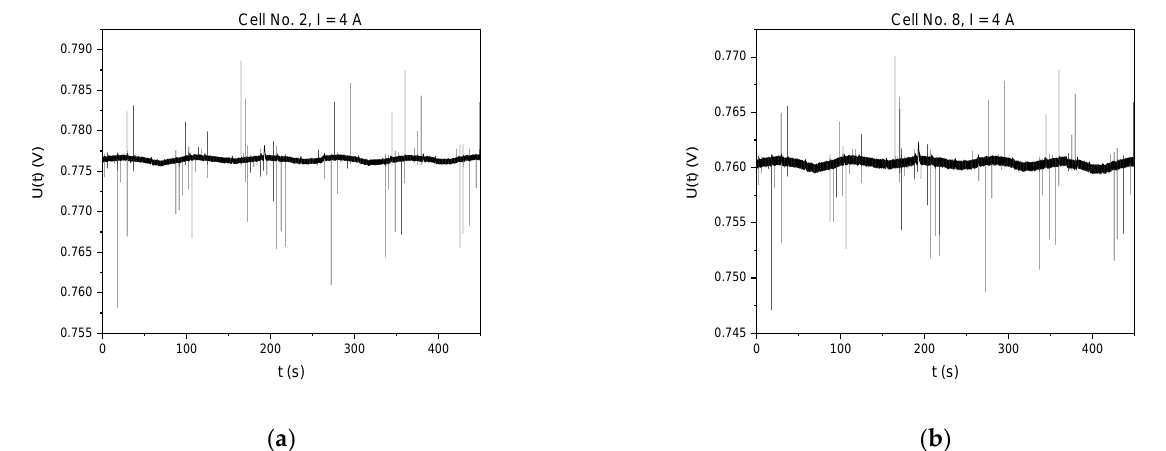
Figure 4. Voltage time series U(t) observed between the cell’s electrodes at a loading current of 4 A: ( a ) cell No. 2, ( b ) cell No. 8.